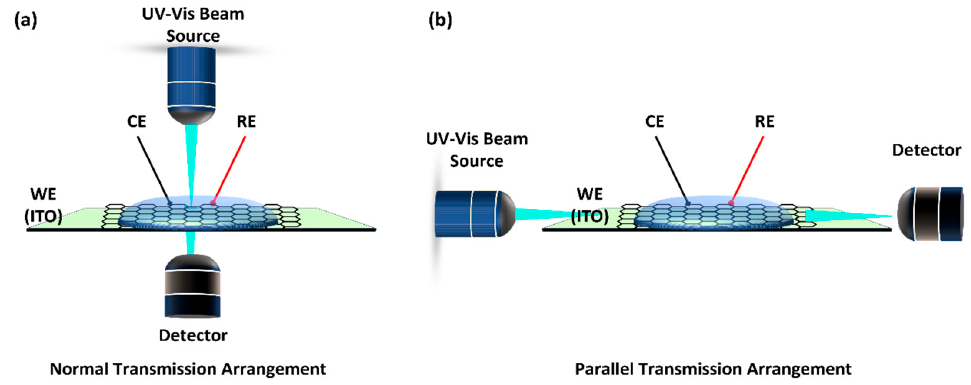
Figure 2. Schematic diagram of two different UV-Vis SEC arrangements. ( a ) Normal transmission arrangement, and ( b ) parallel transmission arrangement.